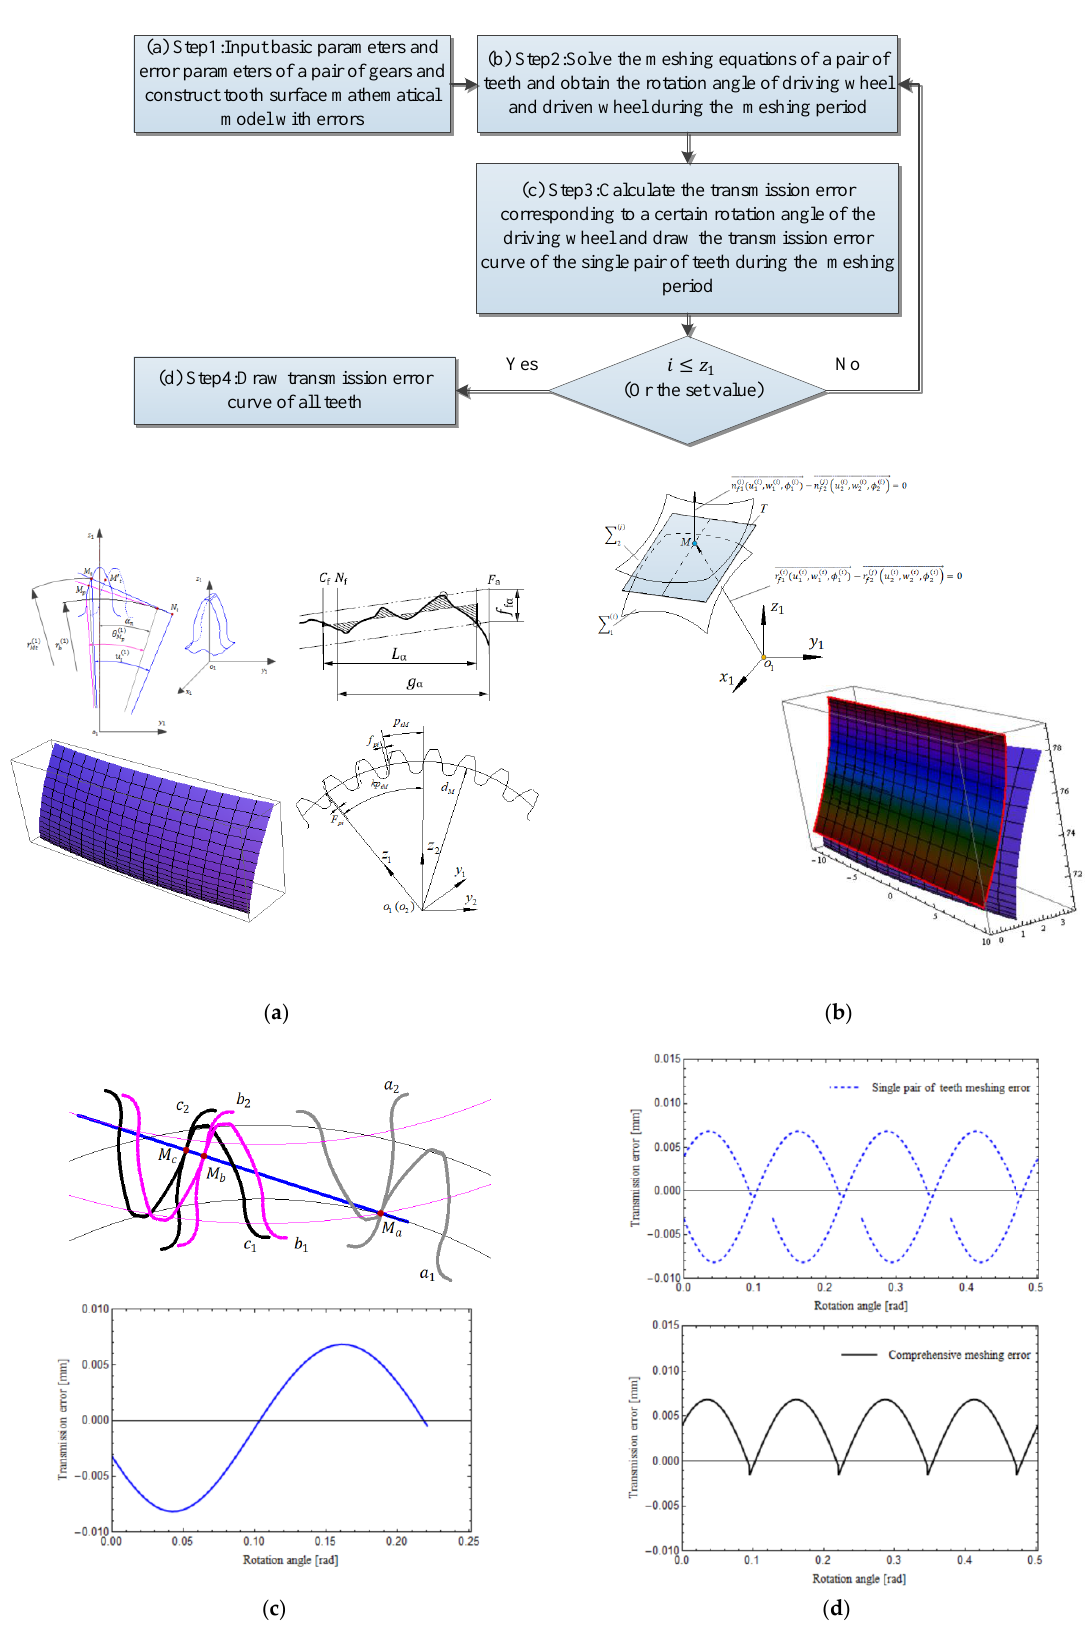
Figure 4. Meshing error calculation and its curve drawing process based on TCA: ( a ) Step 1; ( b ) Step 2; ( c ) Step 3; ( d ) Step 4.